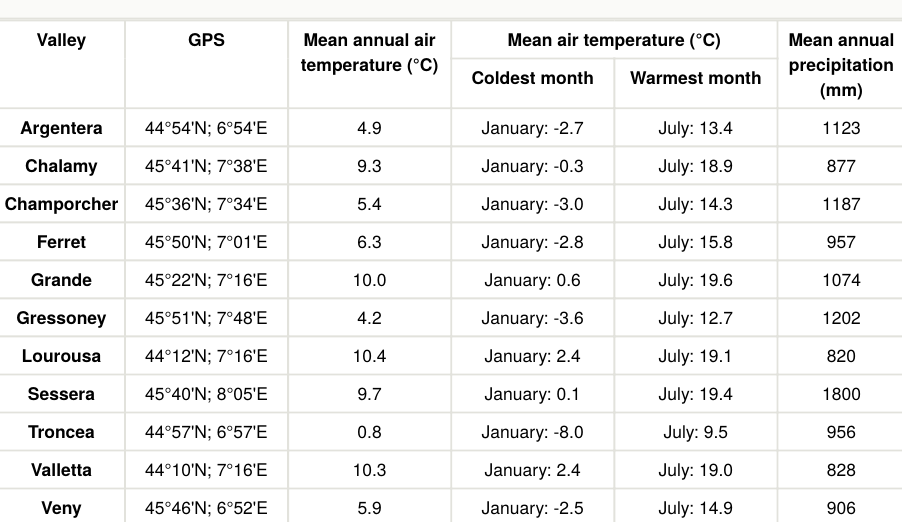
Climatic characteristics of the eleven valleys of the western Italian Alps surveyed from 2005 to 2012 (ARPA